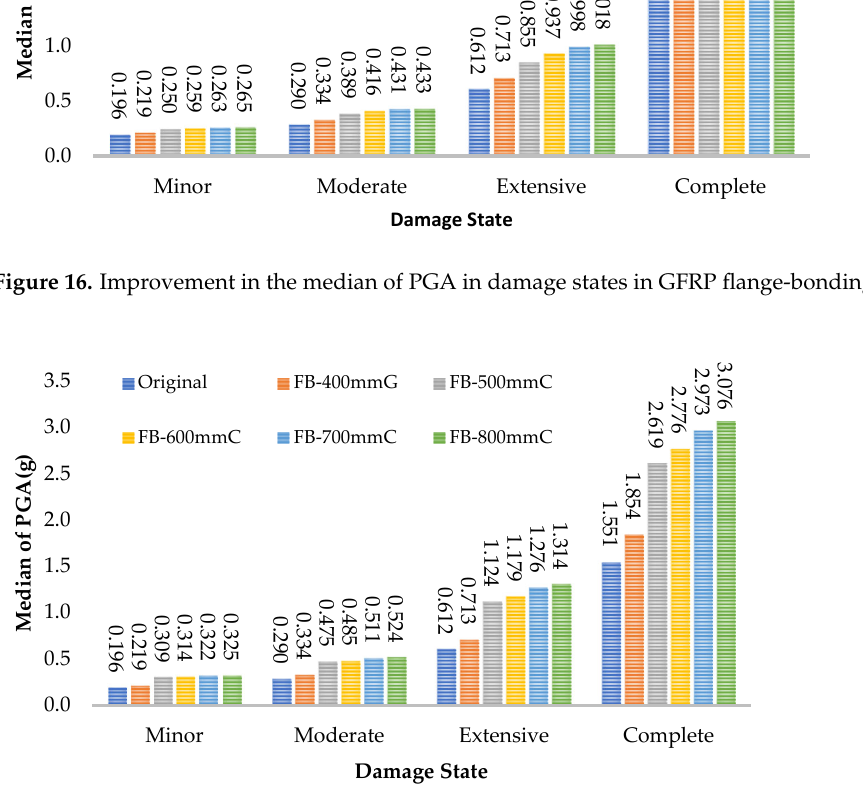
Figure 17. Improvement in the median of PGA in damage states in CFRP flange-bonding frames.